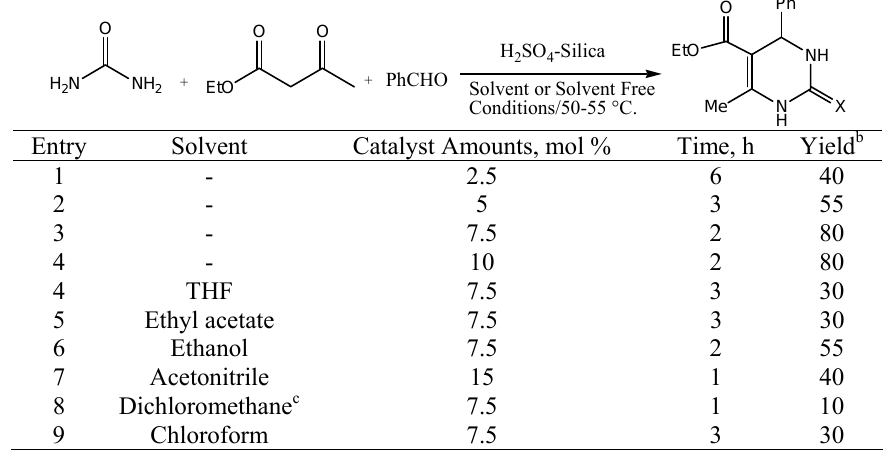
Table 1. Effect of solvent and catalyst amounts of H